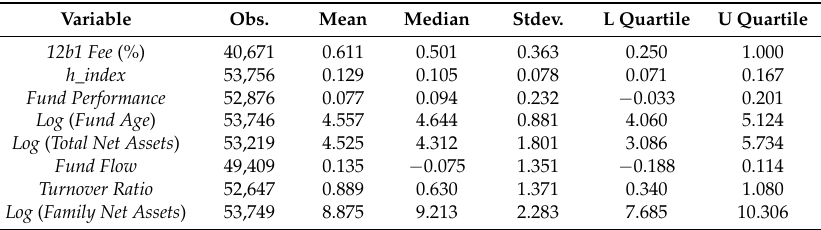
Table 1. Fund characteristics.